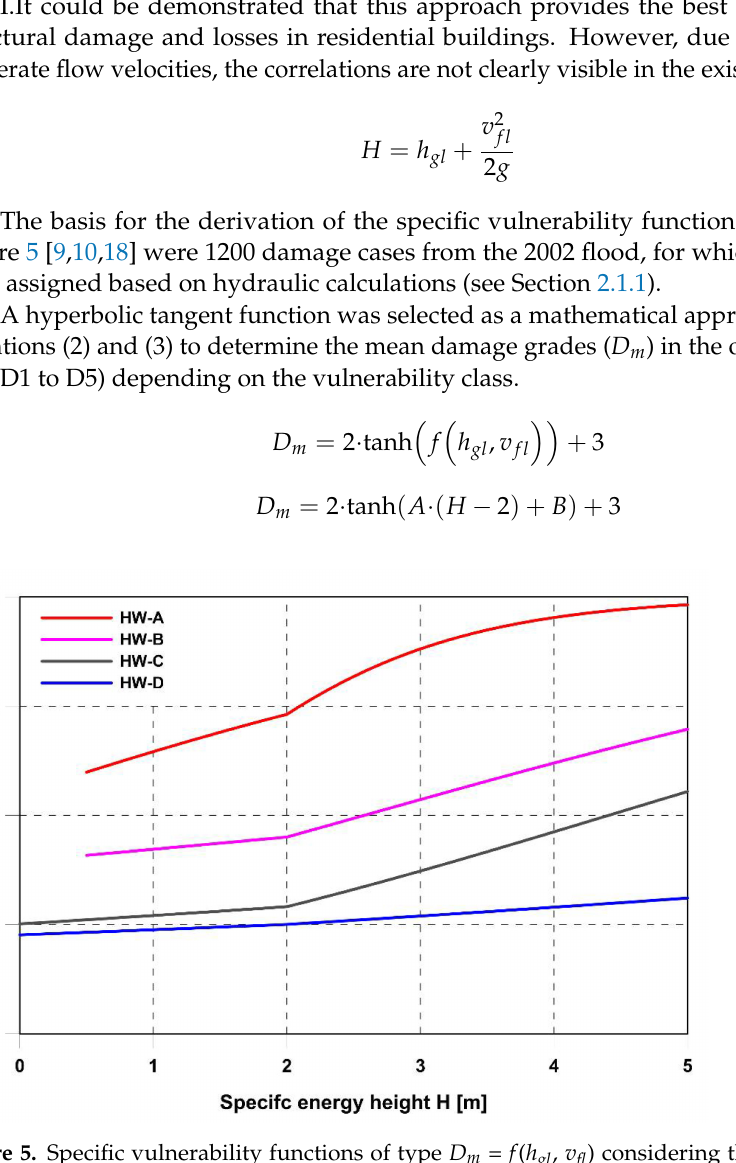
Figure 5. Specific vulnerability functions of type D m = f ( h gl , v fl ) considering the initial five-stage differentiation of damage grades according to previous studies